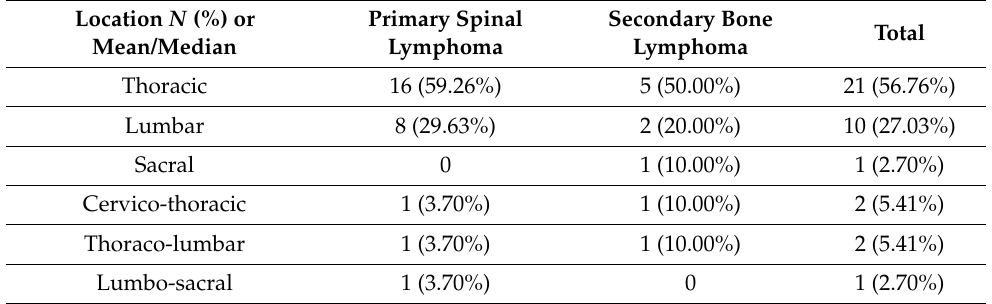
Table 2. Localization of tumor lesions.